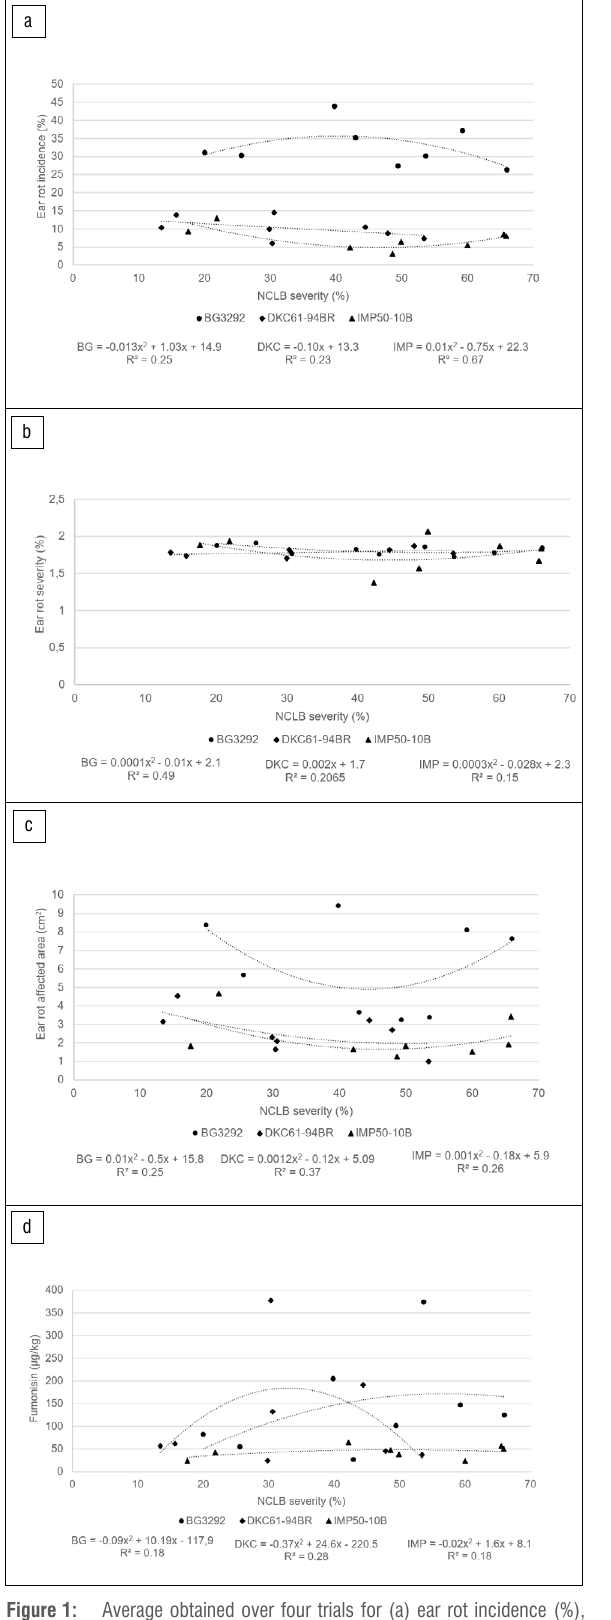
Figure 1: Average obtained over four trials for (a) ear rot incidence (%), (b) ear rot severity (%), (c) ear rot affected area (cm 2 ) and (d) fumonisin concentration (µg/kg) in the grain, regressed against northern corn leaf blight (NCLB) severity achieved at dent stage of eight applied treatments.